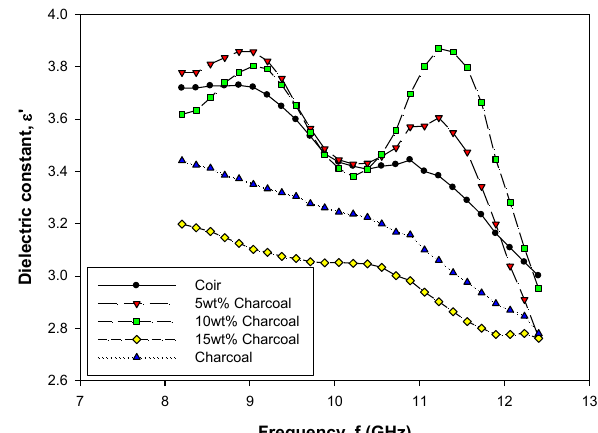
Figure 3 : Dielectric constant of 5 different samples